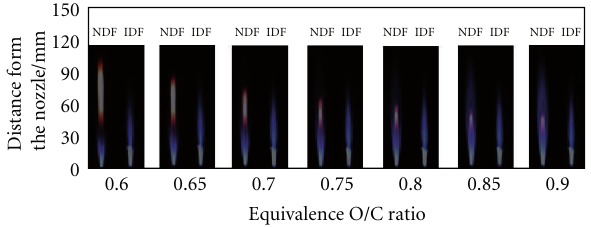
F 4: e comparison of appearance between NDFs and IDFs.